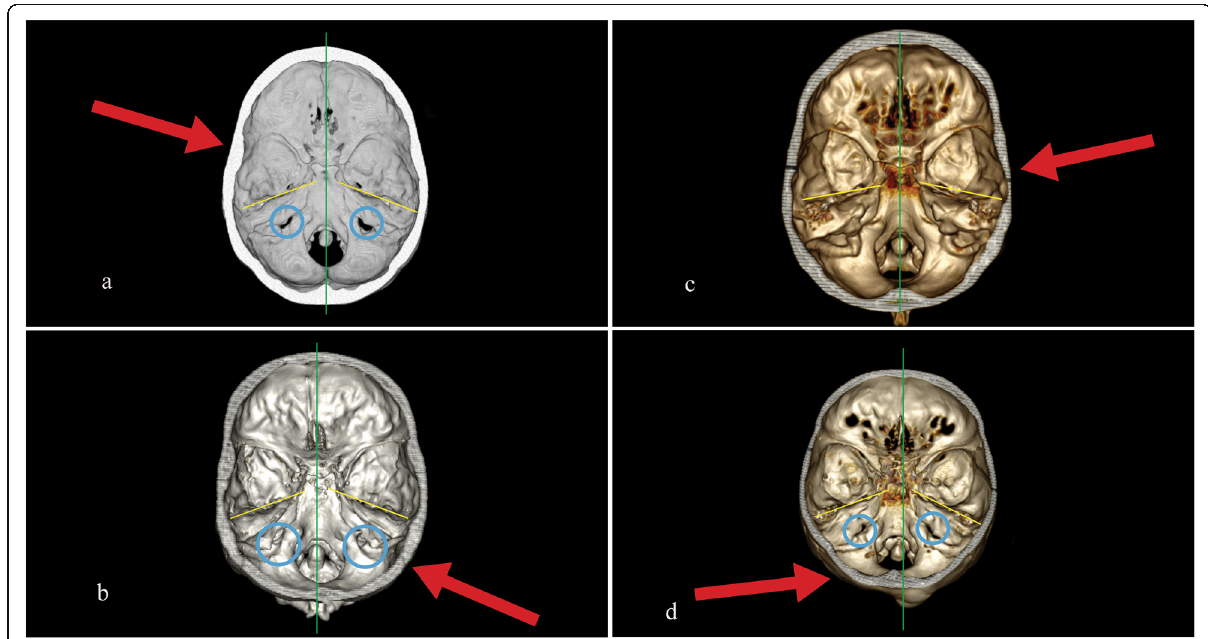
Fig. 2 a Three-dimensional computed tomography (3D CT) of a 23-year-old woman 1 year after head trauma on the left temporal bone. Symptoms: tension-type headache on the left side, dizziness, chronic undernourishment. b 3D CT of a 43-year-old man 10 years after head trauma on the right temporo-occipital suture. Symptoms: severe tension-type headache on the right side, cervical pain. c 3D CT of a 41-year-old woman 1 month after head trauma on the temporal bone. Symptoms: dizziness. d 3D CT of a 47-year-old woman 3 years after trauma on the occipital bone. Symptoms: severe tension-type headache, dizziness, tinnitus. The red arrow shows the direction and the localisation of head impact. The green vertical axis allows us to see the asymmetry of the skull base. The blue rings show the size of the jugular foramen. The yellow lines appreciate the differences in the position of the petrous temporal